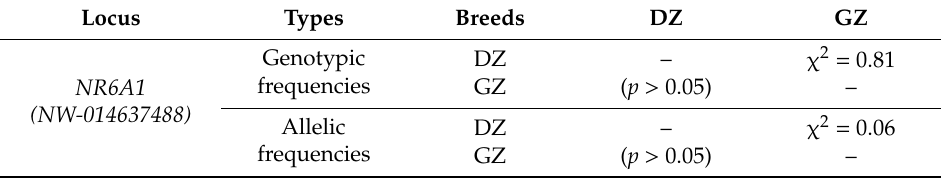
Table 2. χ 2 test of di ff erent breeds on the 13 bp deletion locus of the donkey NR6A1 gene. Locus Types